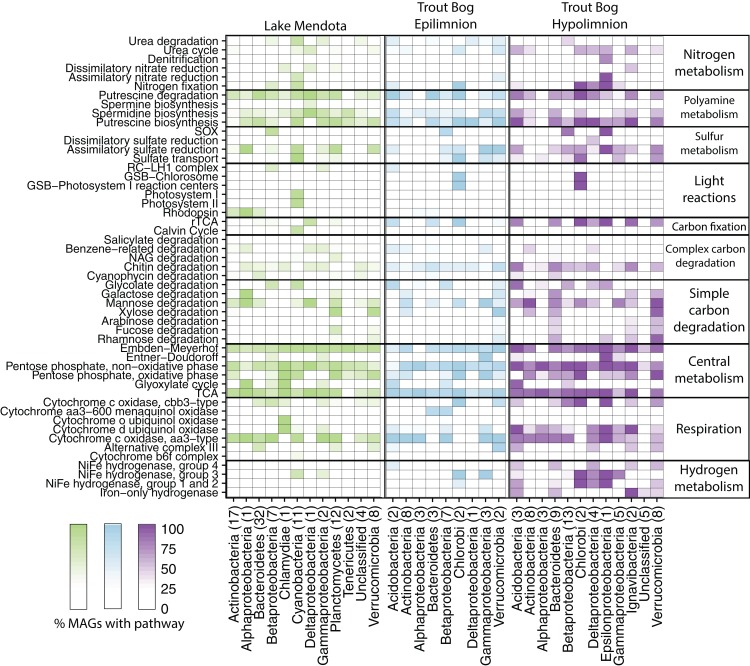
Metabolisms in Mendota and Trout Bog.A pathway was considered present when at least 50% of enzymes in a pathway were encoded in the genome and all enzymes unique to or required for the pathway were present. Putative pathway presence was aggregated by lake and phylum. This analysis can link potential functions identified in the metagenomes to taxonomic groups that may perform those functions. For example, MAGs that putatively fix carbon also likely fix nitrogen in both lakes. Similarly, putative degradation pathways for rhamnose, fucose, and galactose were frequently encoded within the same MAGs. Proteobacteria was split into classes due to the high diversity of this phylum. The number of MAGs assigned to each phylum is indicated in parentheses after the phylum name. Data for each genome can be found in Data S6.